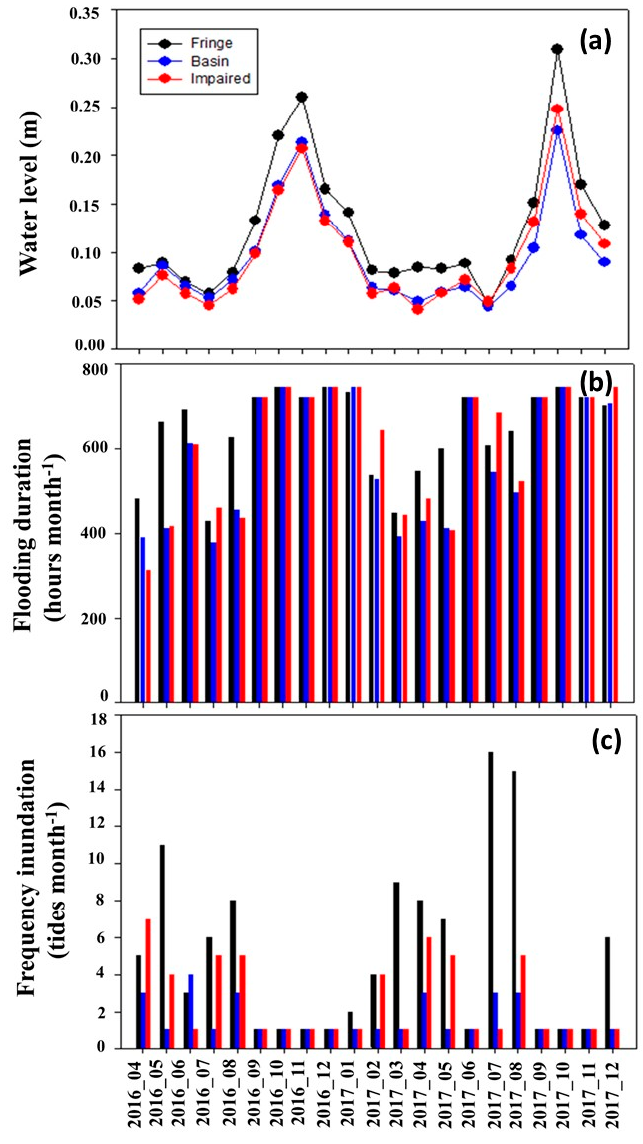
Figure 3. Characteristics of the hydroperiod, ( a ) average level, ( b ) time, and ( c ) flooding frequency; black bars and circles, fringe mangrove; blue bars and circles, basin mangrove; red bars and circles, impaired basin mangrove.